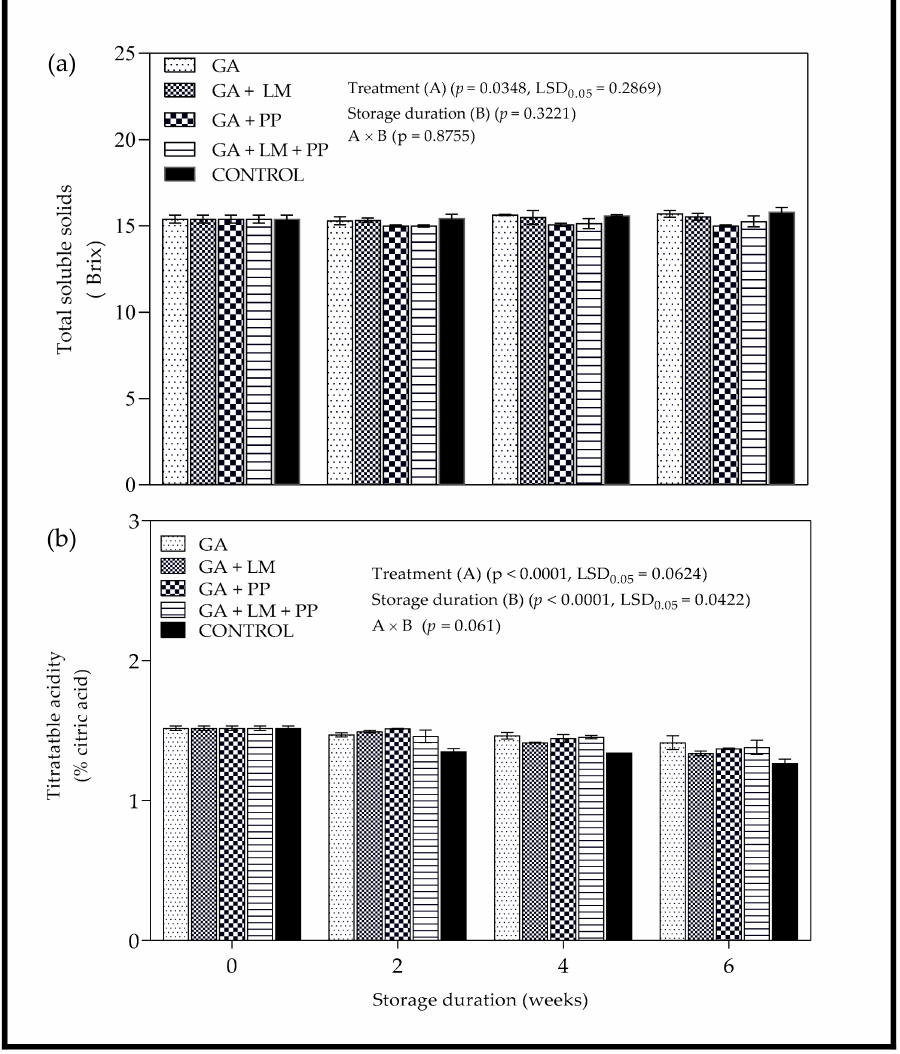
Figure 8. ( a ) Total soluble solids ( ◦ Brix) and ( b ) titratable acidity (% citric acid equivalents) of ‘Wonderful’ pomegranate whole fruit coated with gum arabic (GA) coatings enriched with lemongrass oil (LM) (0.1% v/v ) and/or pomegranate peel extract (PP) (1% w/v ) and stored at 5 ± 1 ◦ C (95 ± 2% RH) for 6 weeks followed by 5 d at shelf-life conditions (20 ± 1 ◦ C and 60% RH). Vertical bars represent the standard error (SE) of mean values calculated from three measurements (Homogenized aril juice extracted from 10 fruit = 1 replicate). LSD 0.05 represent least significant difference ( p <